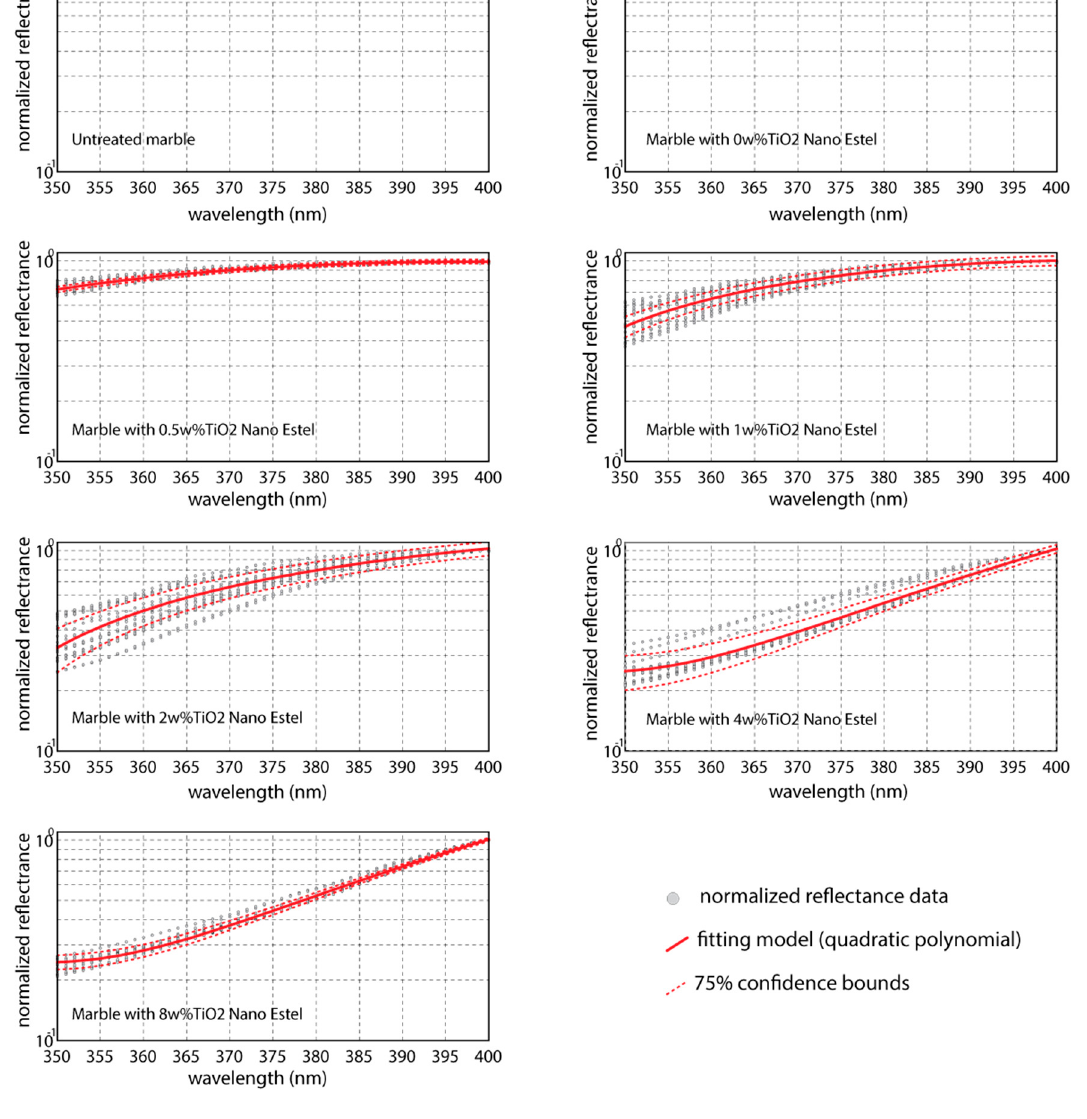
Figure 4. Fitting curves obtained by data regression through quadratic polynomial functions. Data are reflectance values normalized respect to that at 400